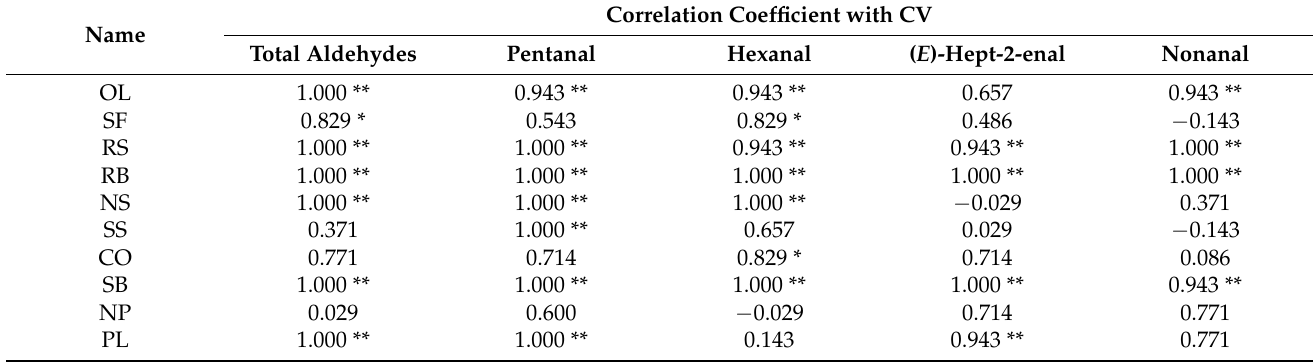
Table 3. Correlation between the peak area of total aldehydes and common aldehydes with the carbonyl value (CV) of 10 types of oil during frying.